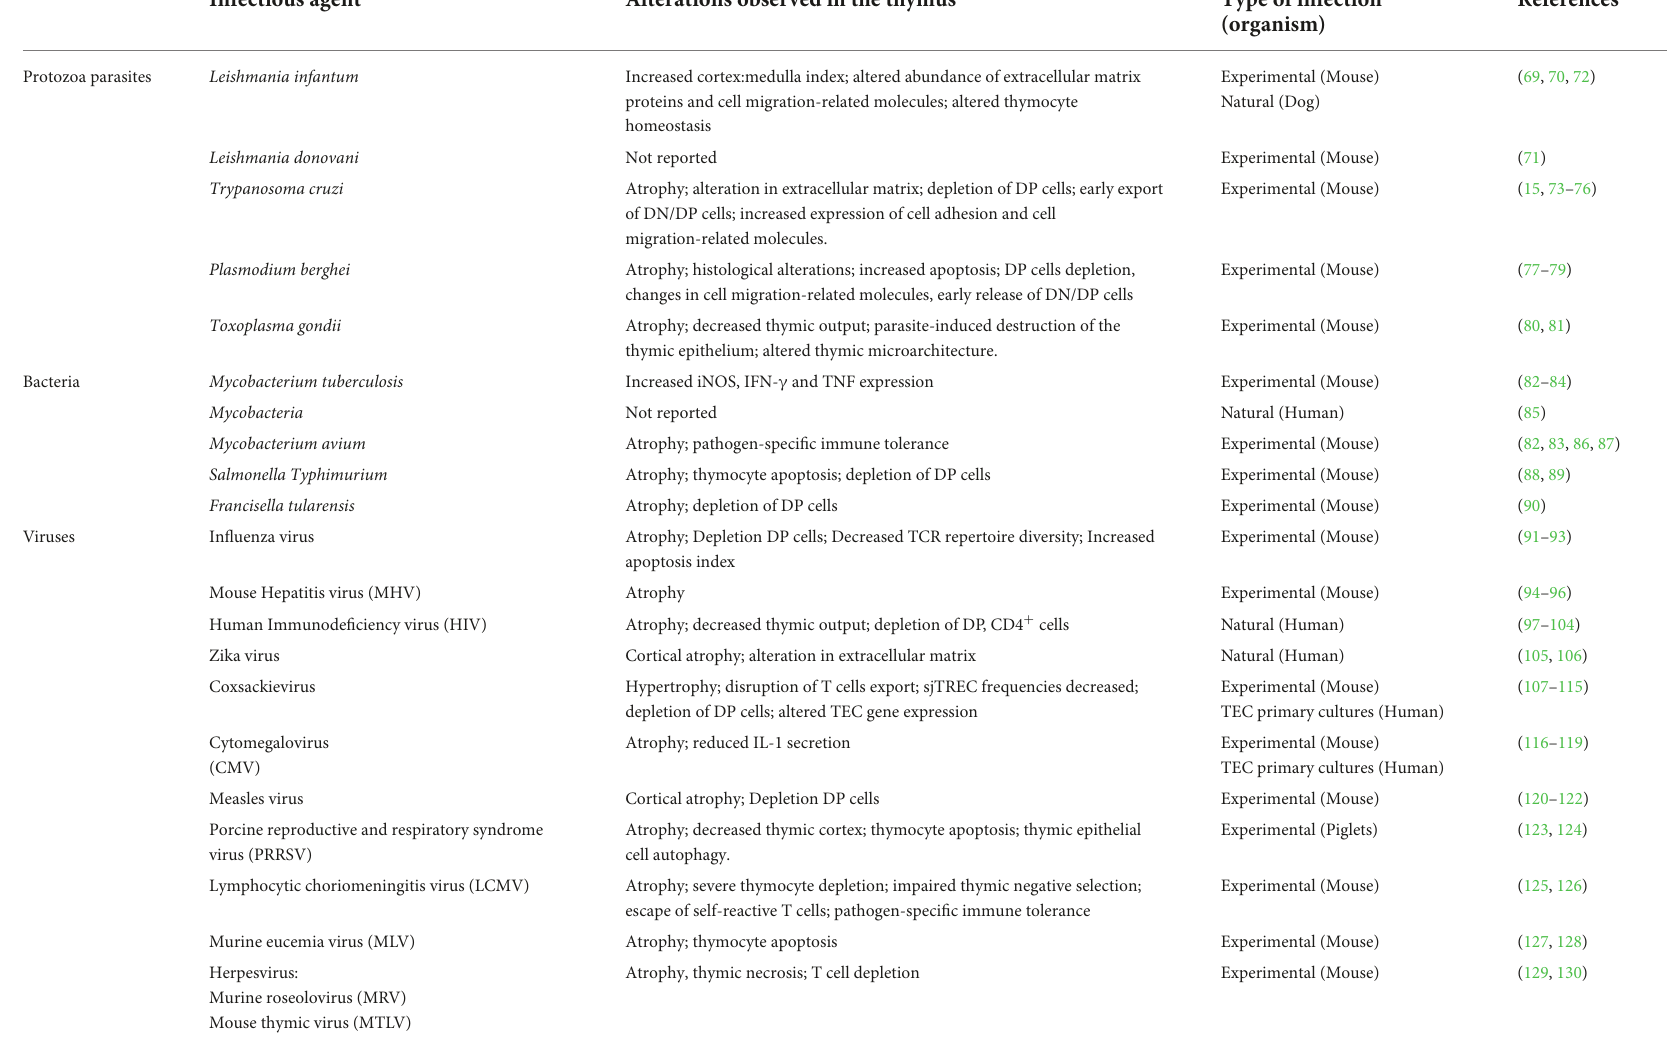
TABLE 1 List of pathogens detected in the